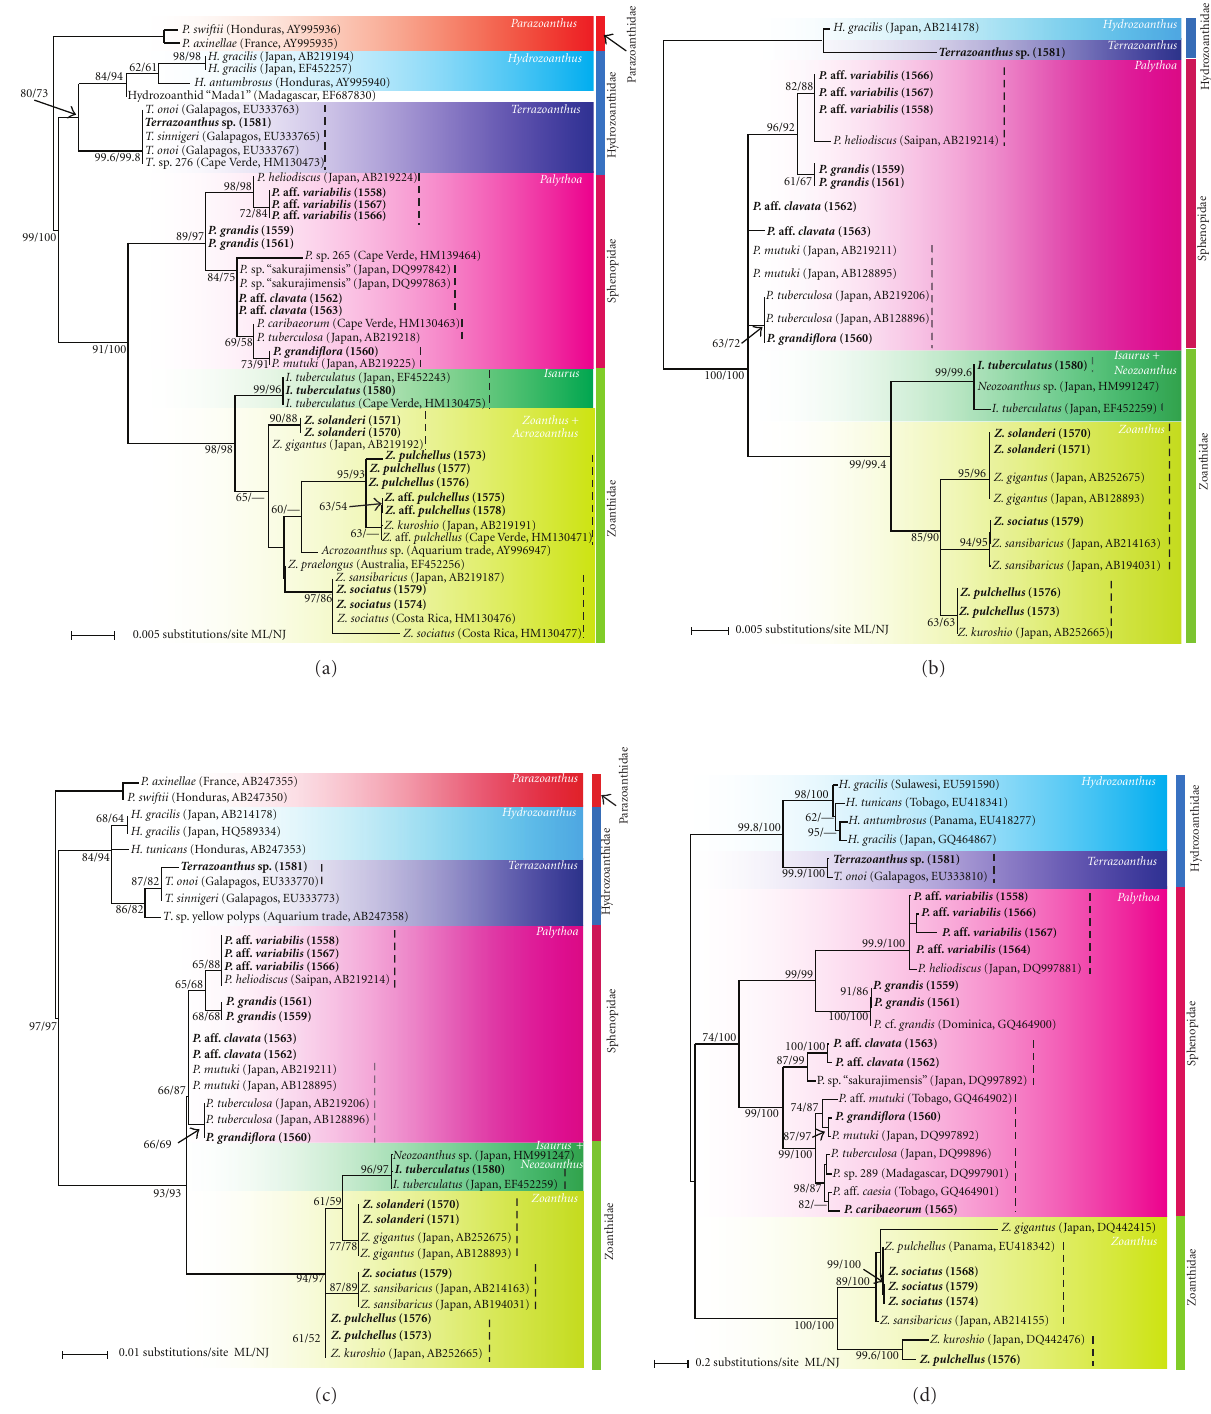
Figure 2: Maximum likelihood trees of (a) mitochondrial 16S ribosomal DNA sequences, (b) “long” alignment of mitochondrial cytochrome oxidase subunit I (COI), (c) “short” alignment of COI, and (d) internal transcribed spacer of ribosomal DNA (ITS-rDNA) sequences. Novel sequences from specimens in this study represented in bold. Sequences/species names from previous studies are in regular font with species name, location, and GenBank accession numbers. Values at branches represent maximum likelihood (ML) and neighbor- joining (NJ) bootstrap probabilities, respectively. Atlantic/Pacific sister species groups are represented by dark dashed lines, groups for which resolution in the phylogenetic tree are weak by gray dashed lines. For specimen information see Table